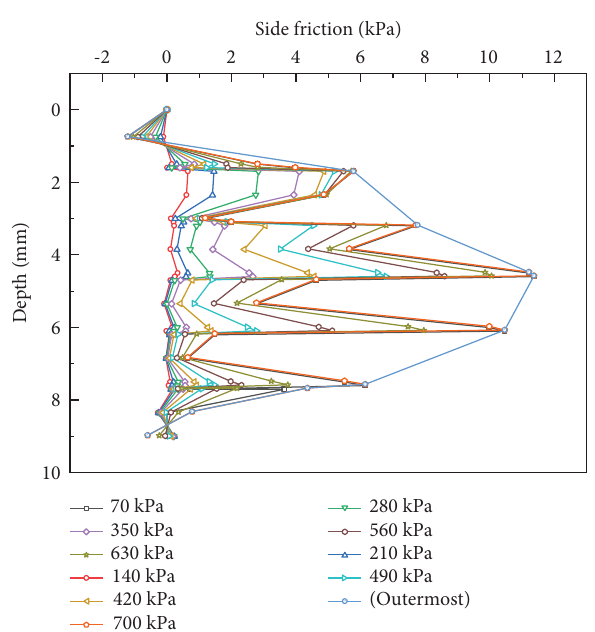
Figure 15: Pile side friction resistance diagram.